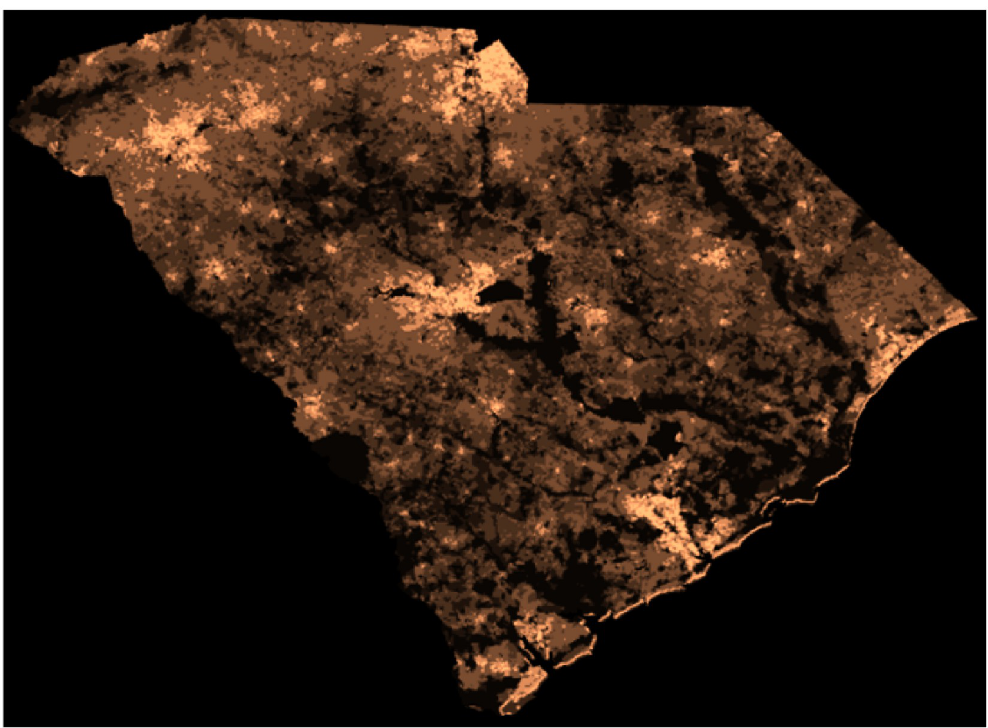
Fig 1. Population density of South Carolina. Bright spots correspond to highly populated regions. Population outsides of the state’s limit was ignored (large dark areas). Adapted from the Center for International Earth Science Information Network—CIESIN—Columbia University. NASA Socioeconomic Data and Application Center (SEDAC) (Creative Commons Attribution 4.0 International License).